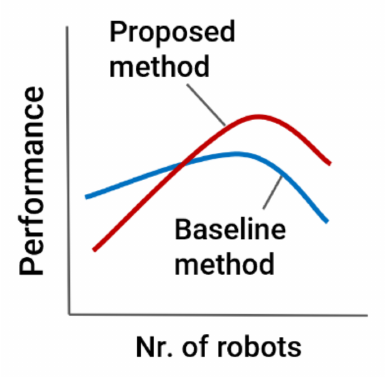
Figure 3. The expected